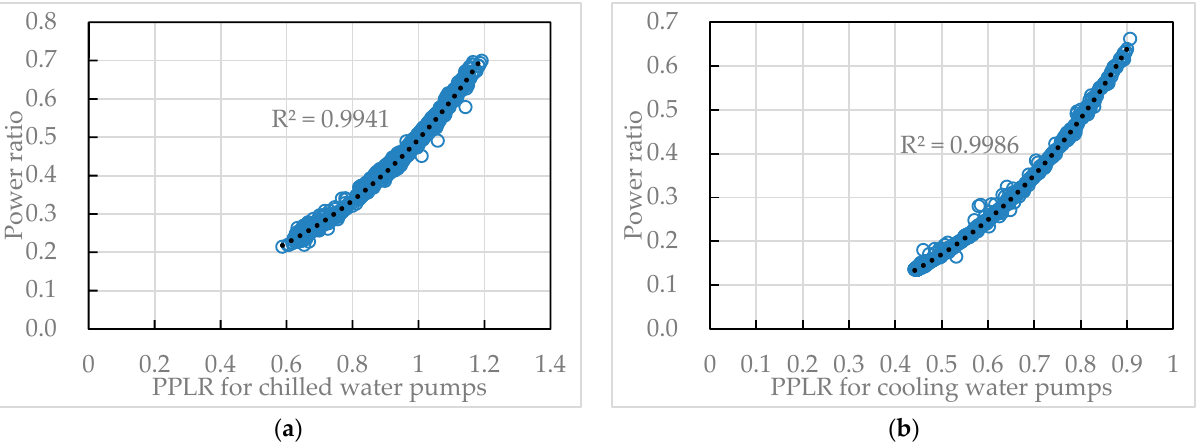
Figure 8. Chilled water pump efficiency curve: ( a ) Chilled water pump; ( b ) Cooling water pump.